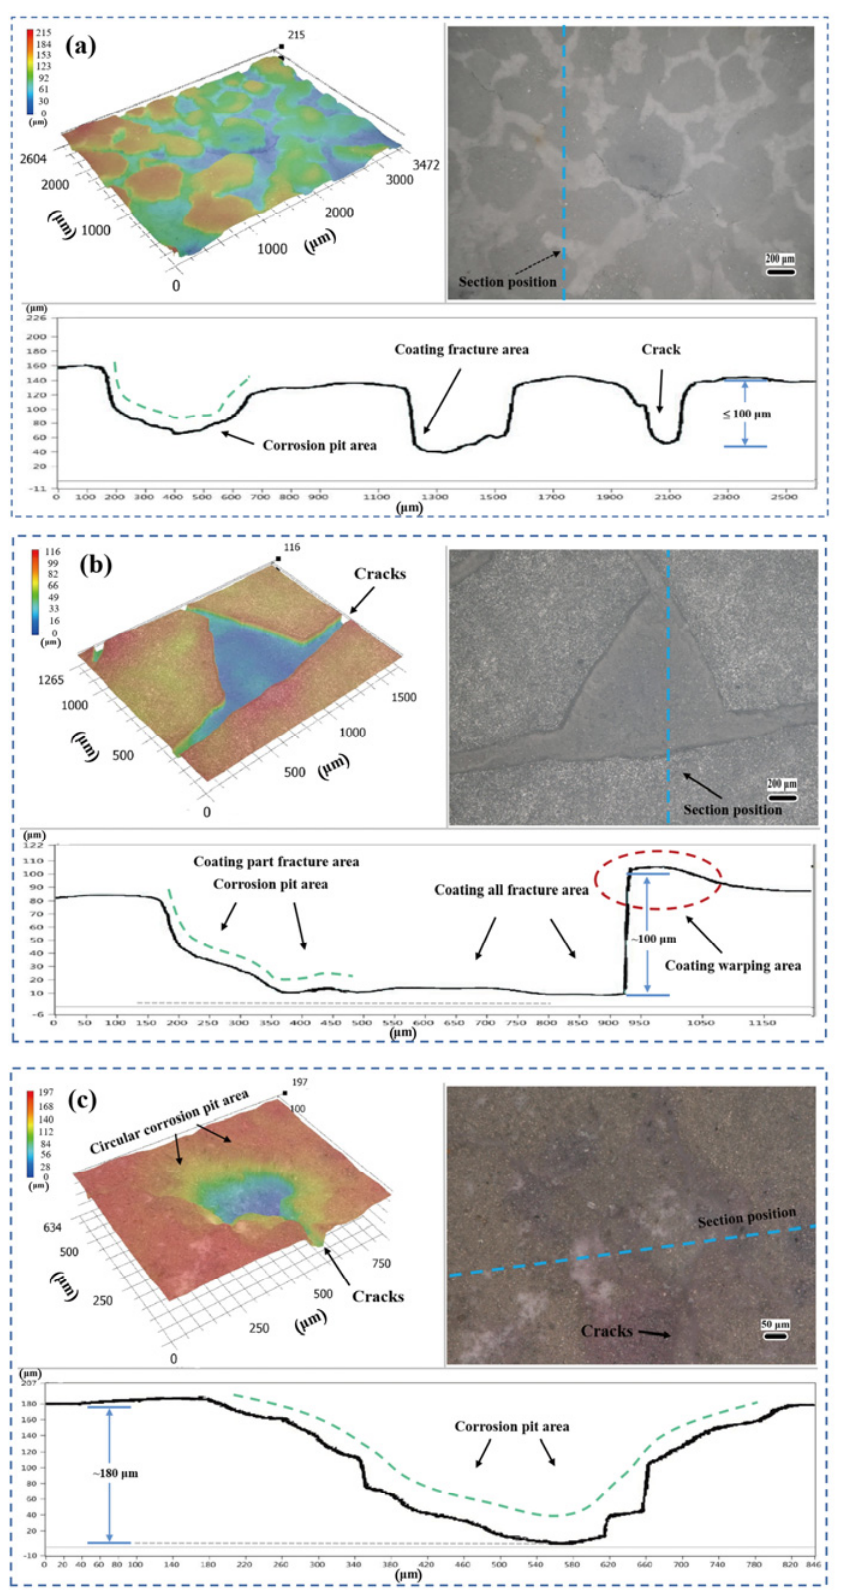
Fig. 14 Surface 3D morphology of (a, b) tri-layer Yb 2 Si 2 O 7 /mullite/SiC and Yb 2 Si 2 O 7 /ASM/SiC coatings-coated C f /SiC samples after 24 thermal cycles, respectively; (c) Yb 2 Si 2 O 7 /SM/SiC coating-coated C f /SiC sample after 36 thermal cycles at 1673